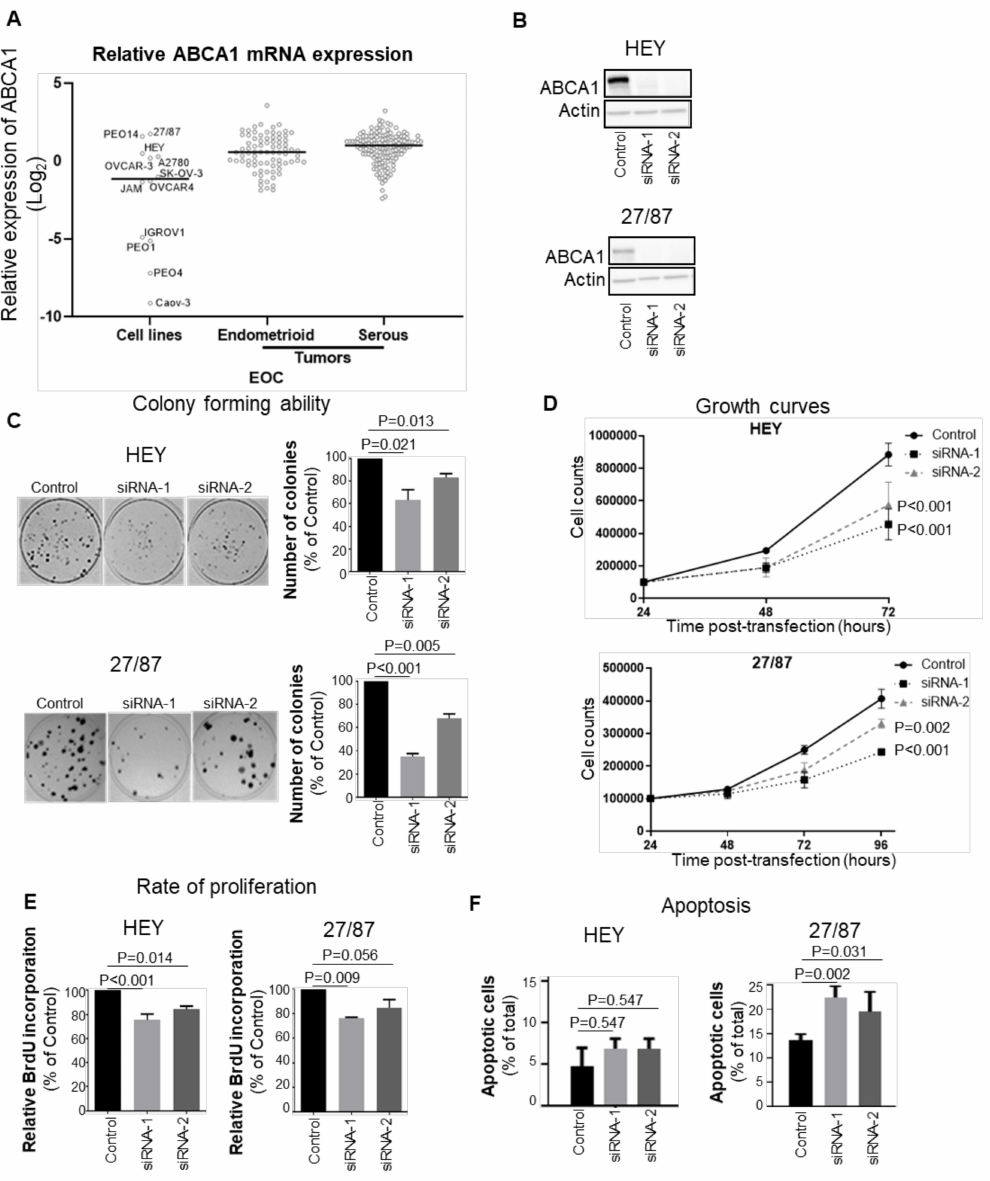
Figure 1. ABCA1 is required for rapid growth of epithelial ovarian cancer (EOC) cells in monolayer. ( A ) RT-qPCR assessment of ABCA1 expression across a panel of cell lines and ovarian cancer tumours. ABCA1 mRNA expression was normalized to the control genes, GUSB and HPRT, and graphed relative to ABCA1 expression in PEO4. Black represents the median ABCA1 expression of the group. ( B ) Western blots showing the extent of the knockdown of ABCA1 by two independent siRNAs in the serous HEY and endometrioid 27/87 cell lines. ( C ) Suppression of ABCA1 impaired the colony forming ability of EOC cells. n = 3. p -Values were derived from one-sample t -tests. ( D ) ABCA1 knockdown reduced the growth of EOC cells, determined by cell counting. n ≥ 3. p -Values were derived from to-way ANOVA with Dunnett’s multiple comparison tests. ( E ) ABCA1 knockdown by siRNA-1 and siRNA-2 reduced the rate of EOC cell proliferation. n = 4 for HEY, n = 3 for 27/87. p -Values were derived from one-sample t -tests. ( F ) ABCA1 knockdown by siRNA-1 and siRNA-2 increased apoptosis in the 27/87 cells as measured by Annexin V and propidium iodide staining. n = 3. p -Values were derived from two-way ANOVA with Dunnett’s multiple comparison test. All results represent the mean ± standard deviation